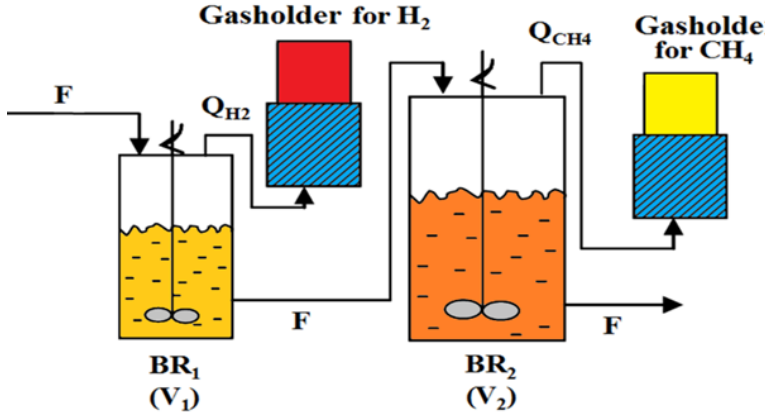
Figure 1. Two-phases process of AD with production of hydrogen ( H 2 ) and methane ( CH 4